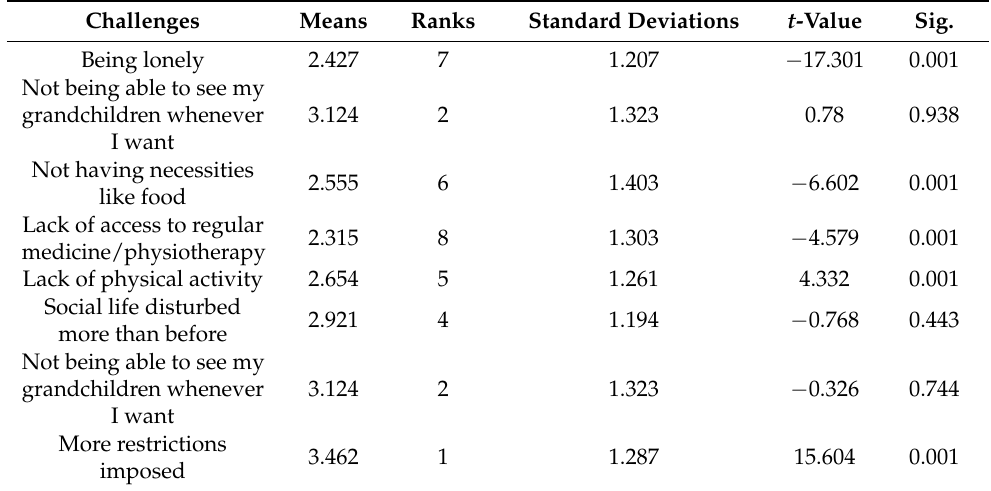
Table 4. Older adults’ major concerns and challenges.